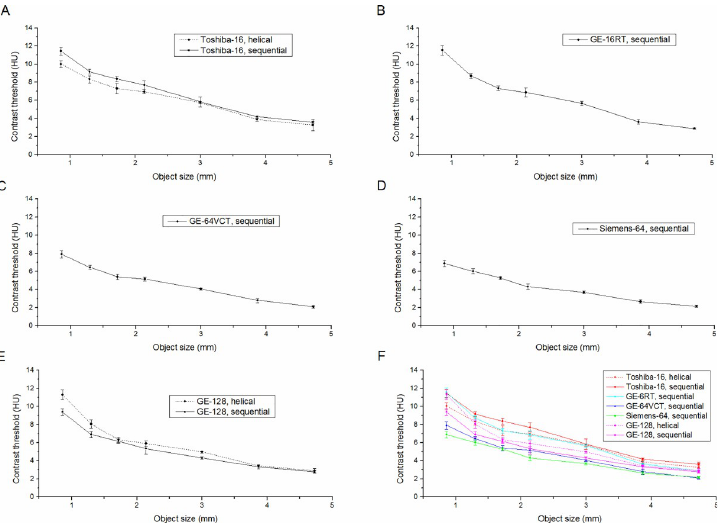
Fig 4. Low-contrast detectability (LCD) curves of images acquired using different CT scanners/acquisition protocols. Panels A, B, C, D and E show the LCD curves (mean ± standard deviation across five repeated measurements) for Toshiba-16, GE-16RT, GE-64VCT, Siemens-64 and GE-128 scanners, respectively. In order to better compare the different LCD curves, Panel F shows on the same graphic the LCD curves for all scanners/ acquisition